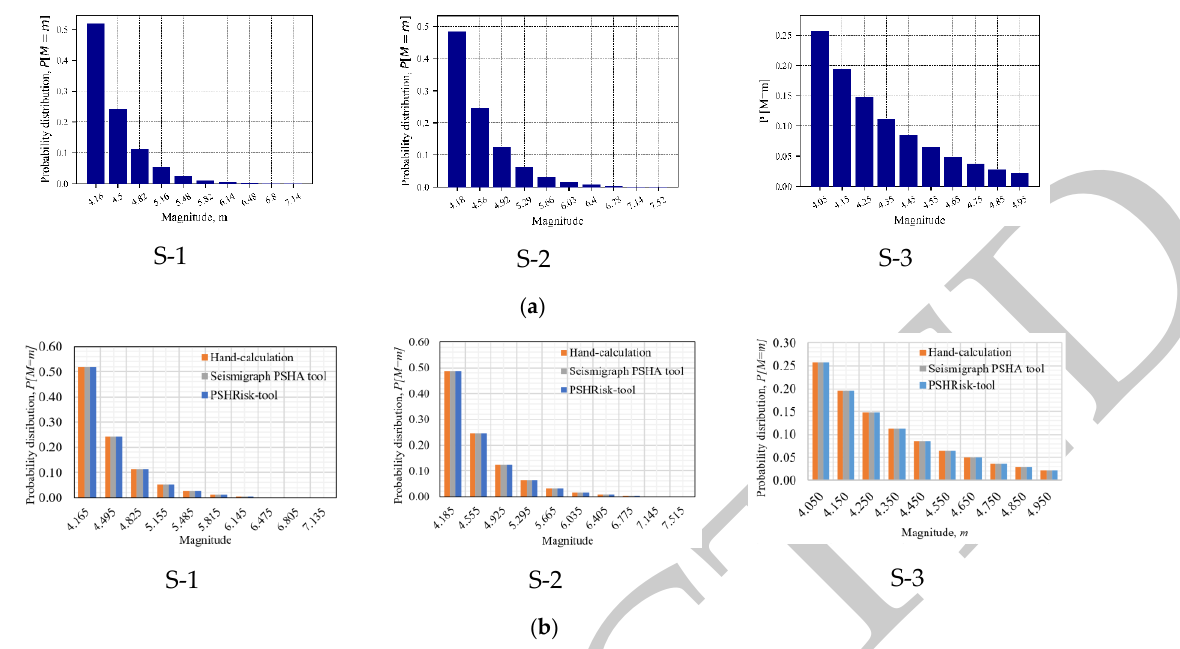
Figure 6. Verification for the probability distribution of distance, ( a ) PSHRisk-tool view, ( b ) Comparison.